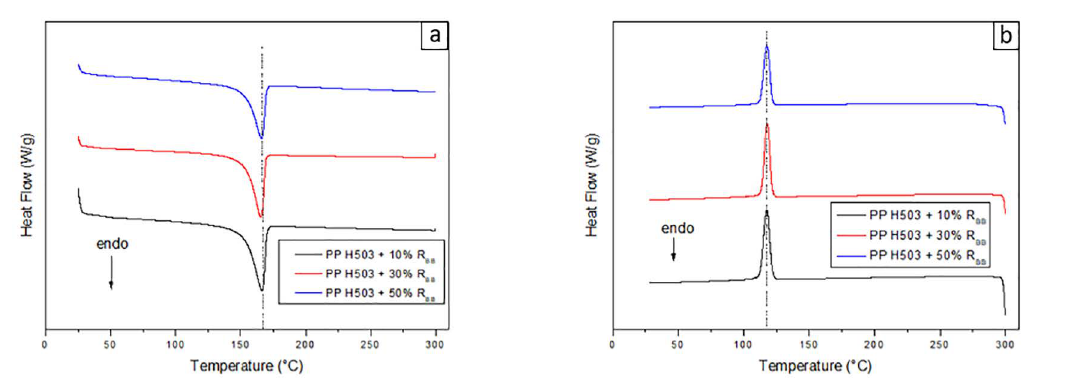
Figure 5. DSC curves of PP H503 compounds acquired during heating (a) and cooling (b) at 10ºC/min.